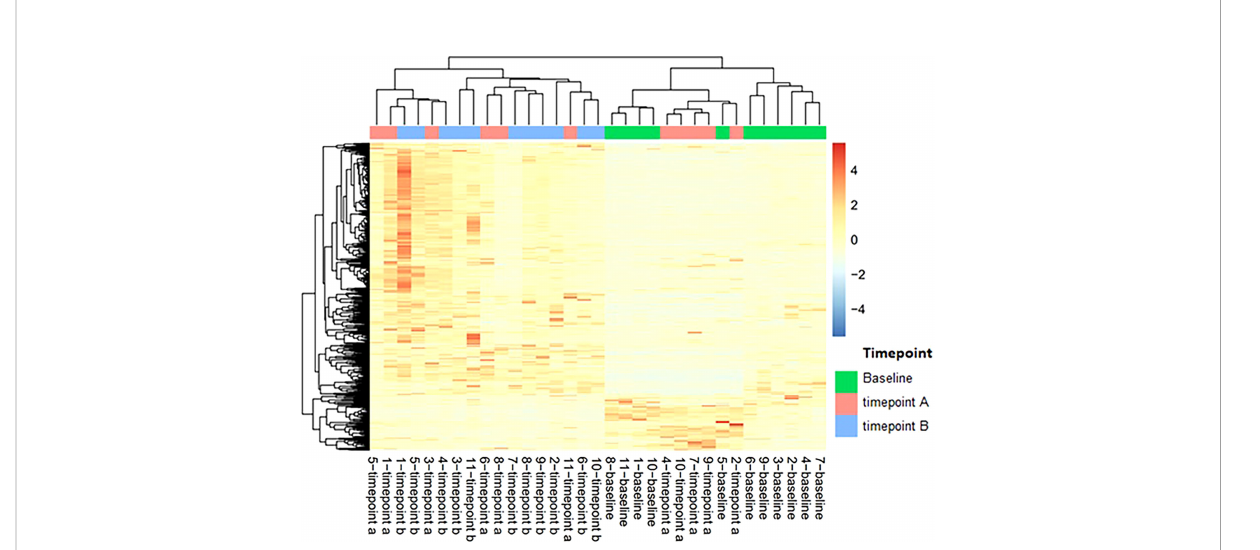
FIGURE 4 Heatmap of extracellular vesicle protein expression with hierarchical clustering of signatures by patient and timepoint. Timepoint A corresponds to week 12 on-treatment. Timepoint B corresponds to weeks 60-84 off-treatment. Patients 4, 5, 7, and 10 developed